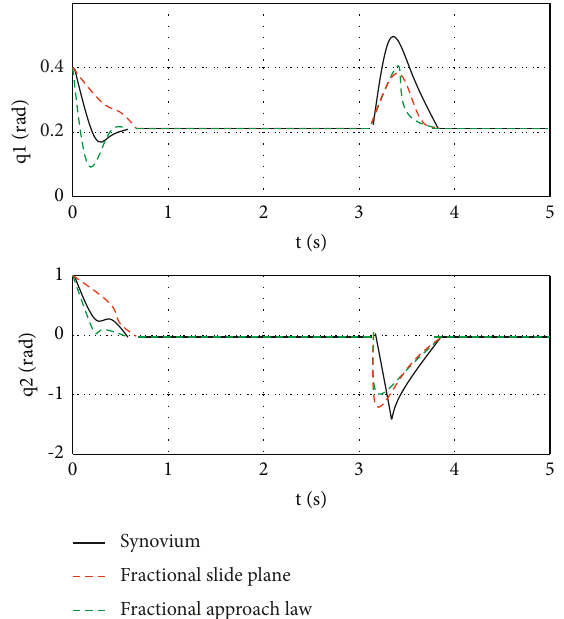
Figure 3: Comparison curve of position error of the three control strategies under aperiodic